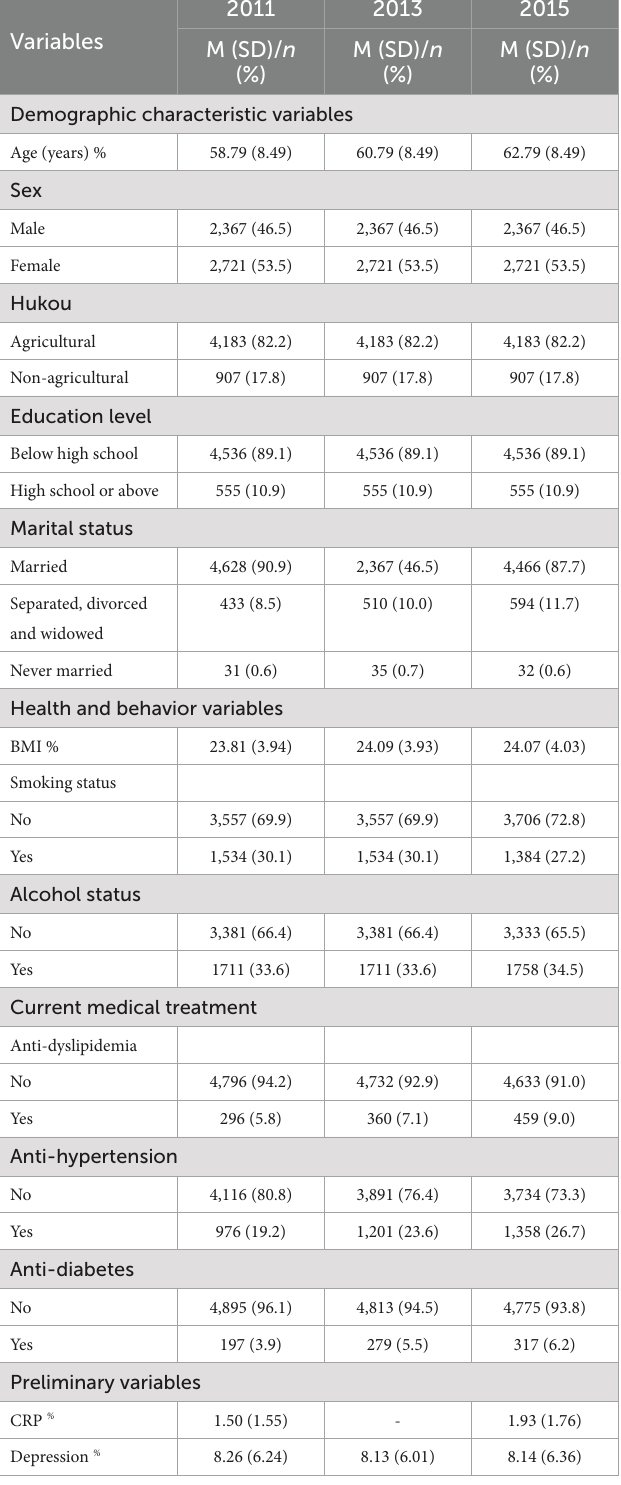
TABLE 1 Characteristics of participants ( N =